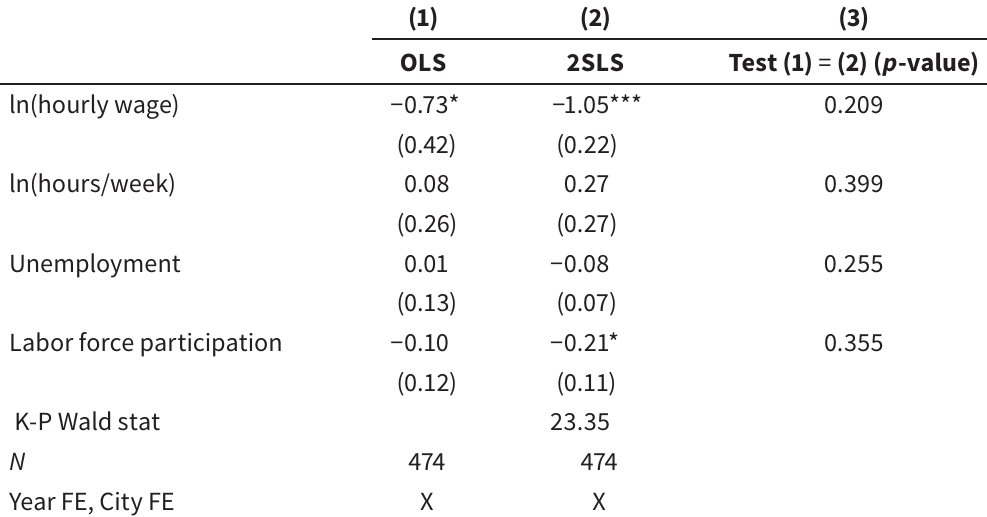
Table 1 Labor market effects of immigration